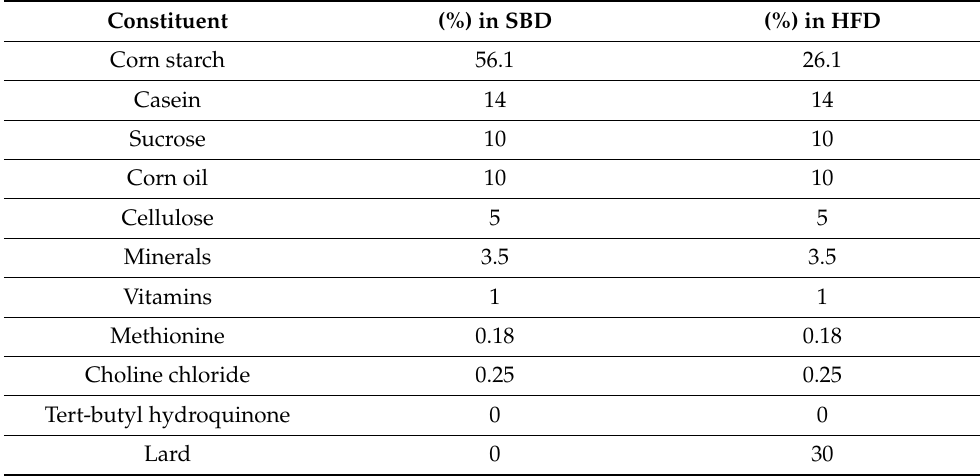
Table 4. Chemical composition of the SBD and HFD.